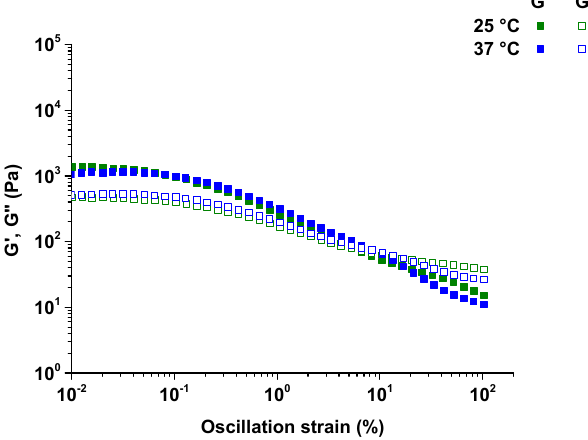
Figure 6. Amplitude sweeps performed from 0.01% to 100% of oscillation strain at 25 and 37 °C on hydrogels prepared with 10% P-10K and 10% α -CD.